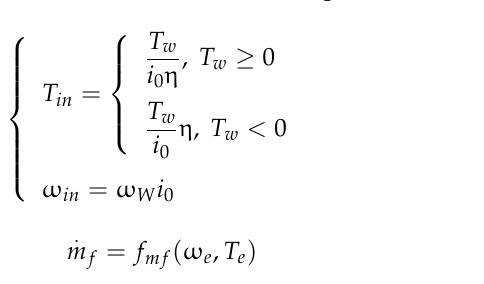
Figure 2. Linear fitting curve of engine fuel consumption rate and torque.